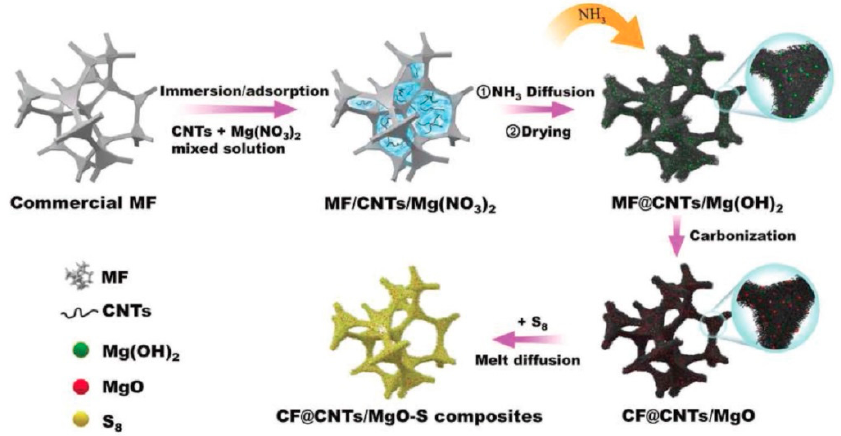
Figure 10. Preparation of a MgO/carbon nanotube/carbon foam composite material. MF—melamine foam, CF—carbon foam, CNTs—carbon nanotubes. Reprinted from [160] with permission from John Wiley and Sons.